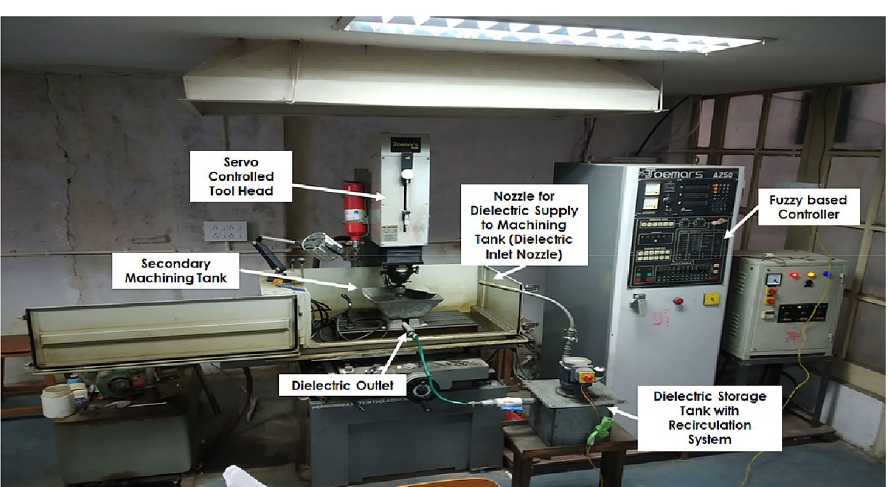
Fig. 1 Experimentation setup